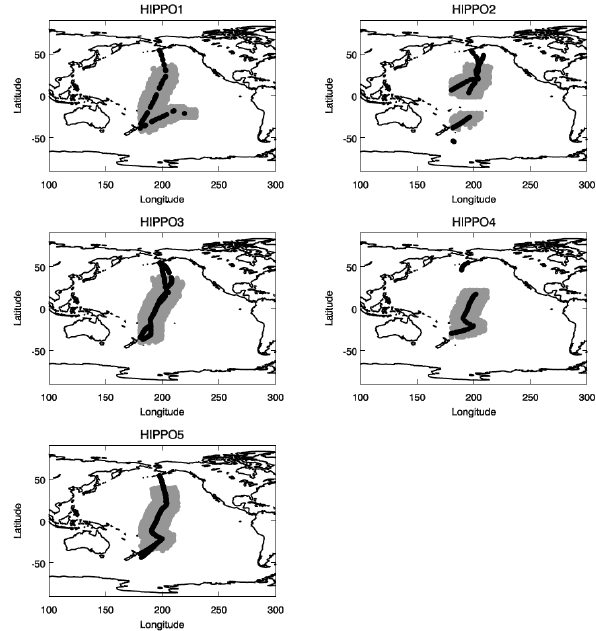
Fig. 7 HIPPO campaign trajectory in black dots. The gray region shows the coverage Fig. 7. HIPPO campaign trajectory in black dots. The gray region of overpassed TES measurements within the grid box of ± 10° about each HIPPO shows the coverage of overpassed TES measurements within the measurement and during the ± 15 days period of the years from 2006 to 2010. Both grid box of ± 10 ◦ about each HIPPO measurement and during the of the HIPPO and TES OCS profiles are vertically averaged between 900 hPa and 200 ± 15day period of the years 2006–2010. Both of the HIPPO and hPa and latitudinal averaged onto regular grids from 35°S to 35°N every 10°. TES OCS profiles are vertically averaged between 900 and 200hPa and latitudinally averaged onto regular grids from 35 ◦ S to 35 ◦ N every 10 ◦